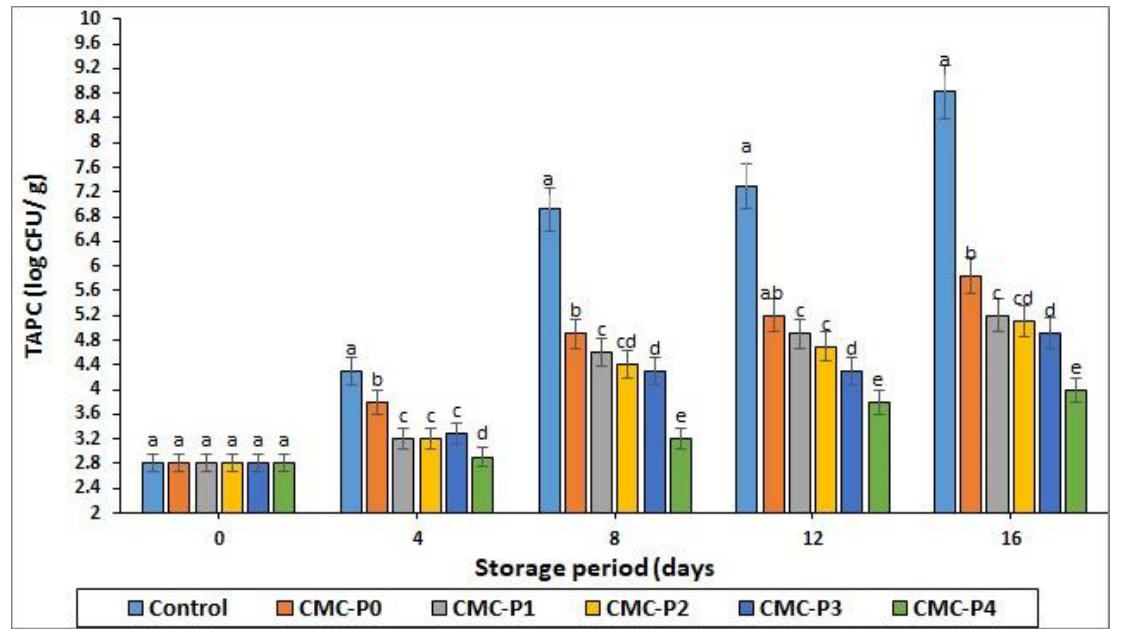
Figure 6. The impact of applied coatings on the TAPC of chicken breast meat samples during storage at 2 °C for 16 days. Control : Uncoated chicken breast meat samples (soaked samples in sterile dis- tilled water). CMC-P0 : CMC-coated chicken breast meat samples with 0% EPE. CMC-P1 : CMC- coated chicken breast meat samples with 1% EPE. CMC-P2 : CMC-coated chicken breast meat sam- ples with 2% EPE. CMC-P3 : CMC-coated chicken breast meat samples with 3% EPE. CMC-P4 : CMC-coated chicken breast meat samples with 4% EPE. a – e : Within a column, different superscripts indicate significant differences ( p ≤ 0.05